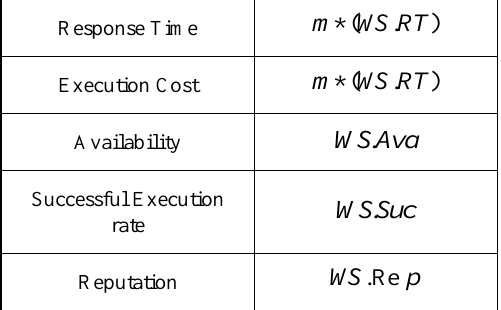
Table 3. Aggrigative QoS value for a cycle